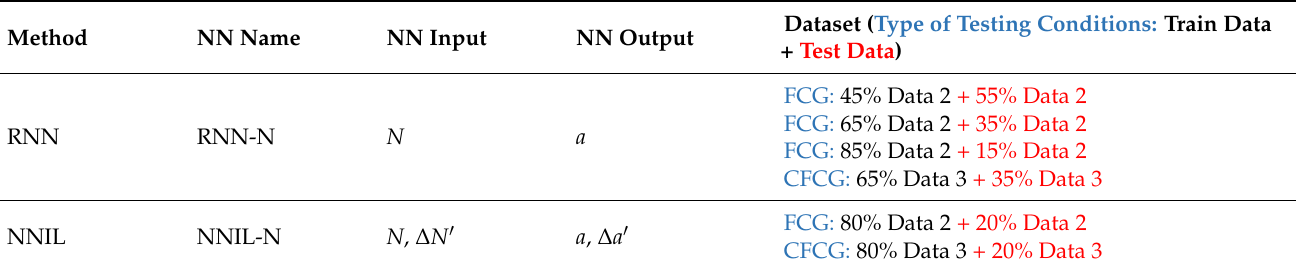
Table 5. List of modelling cases using RNN and NNIL method.